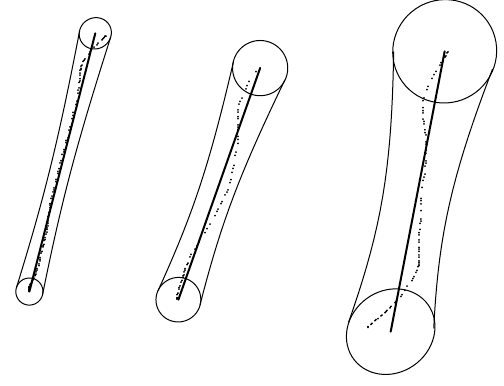
Figure 2. Strokes with different precisions depicited by the con- fidence regions of the approximating straight line segments. The confidence regions are most narrow close to the centroid of the corresponding point